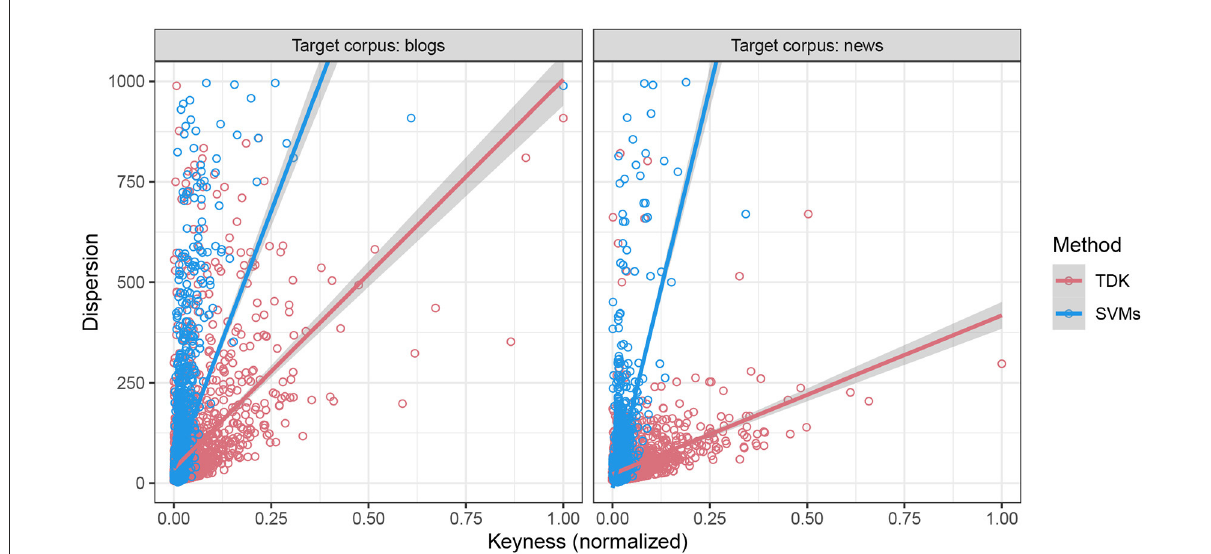
FIGURE4 The relationship between dispersion and normalized keyness estimated with SVMs and TDK with 95% CIs. The columns correspond to the target corpus.